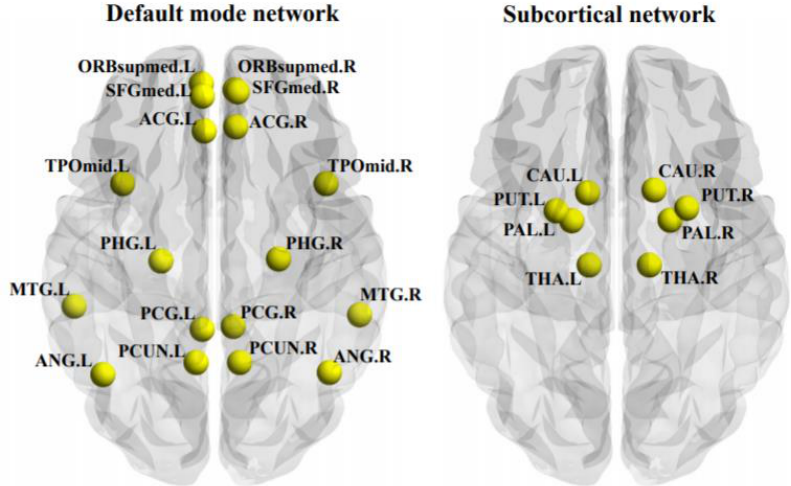
Figure 3. The components of the default mode network and subcortical network, of which the temporal correlation coefficients were significantly decreased in the patients with major depressive disorder. ACG, anterior cingulate cortex; ANG, angular gyrus; CAU, caudate; L, left hemisphere; MTG, middle temporal gyrus; ORBsupmed, medial orbitofrontal cortex; PAL, pallidum; PCUN, precuneus; PHG, parahippocampal gyrus; PUT, putamen; R, right hemisphere; SFGmed, medial superior frontal cortex; SPG, superior parietal gyrus; THA, thalamus; TPOmid, middle temporal pole.